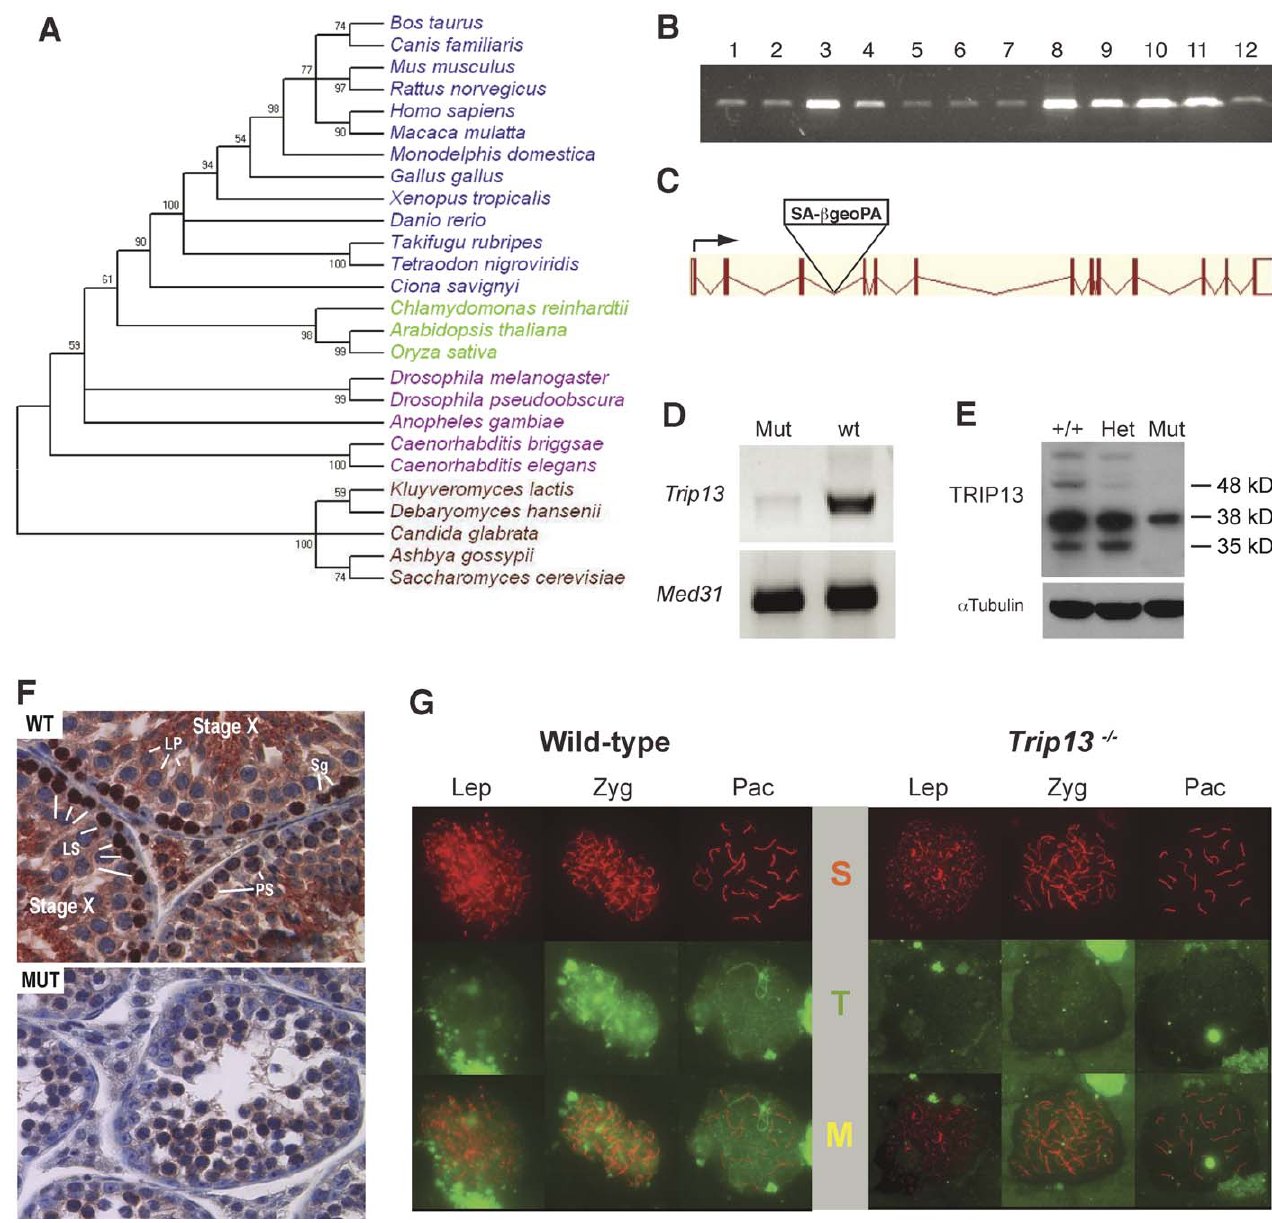
Figure 1. The Mouse PCH2 Ortholog TRIP13 and Expression in Wild Type and Mutant (A) Phylogenetic tree of presumed PCH2/TRIP13 orthologs. The database sequence accession number of each protein is presented in Table S1. Numbers shown are bootstrap values (see Materials and Methods). The clustering was the same regardless of whether the whole entire AA sequence or trimmed sequences (where regions showing little conservation were removed) were used for the analysis. Major eukaryotic groups are indicated in color, with deuterostomia in blue, plants in green, protostomia in purple, and fungi in maroon. (B) Amplification products of cDNA from the following tissues: 1, heart; 2, brain; 3, spleen; 4, lung; 5, liver; 6, skeletal muscle; 7, kidney; 8, testis; 9, E7 embryo; 10, E11 embryo; 11, E15 embryo; and 12, E17 embryo. (C) Intron–exon structure of TRIP13 and insertion site of gene-trap vector. See Materials and Methods for details on how the precise insertion site was identified. (D) RT-PCR of Trip13 and a control gene Med31 from testis RNA. The Trip13 primers are situated in the first and last exons (see Materials and Methods). (E) Western blot analysis of testis protein with anti-TRIP13 antibody. The blot was later probed with anti-alpha tubulin actin as a loading control. The expected TRIP13 protein is ; 48 KDa. (F) Localization of TRIP13 in testes. Wild-type (top) and mutant (bottom) testis sections were probed with chicken anti-TRIP13, and detected with HRP- conjugated anti-chicken IgG (brown/red staining). Expression in WT was most prominent in the nuclei of Type B spermatogonia (Sg), leptotene spermatocytes (LS), and early pachytene spermatocytes (PS), but not late pachytene spermatocytes (LP). No nuclear staining was seen in mutant testis sections, although reddish cytoplasmic background is present. Identification of cell types was judged in part by estimating the epithelial stage of the tubules as described [67]. (G) TRIP13 localization in surface-spread spermatocytes. Preparations were immunolabeled with anti-SYCP3 (S) and TRIP13 (T). Both individual and merged images are shown for leptotene (Lep), zygotene (Zyg), and pachytene (Pac) spermatocytes. Nuclear staining was absent in the